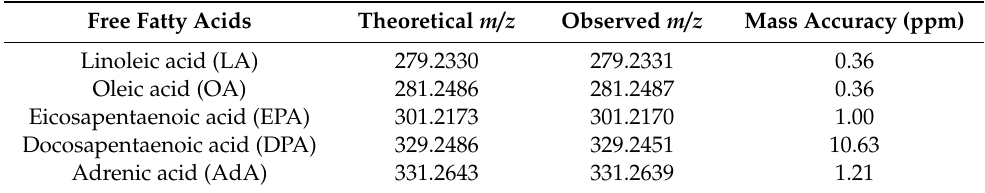
Table 2. m / z accuracy of targeted molecules.